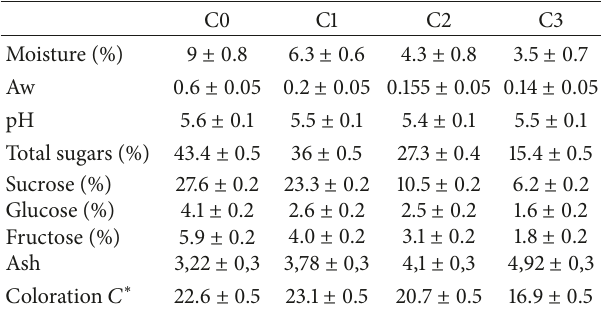
Table 1: Physicochemical characterization of initial and roasted carob pod